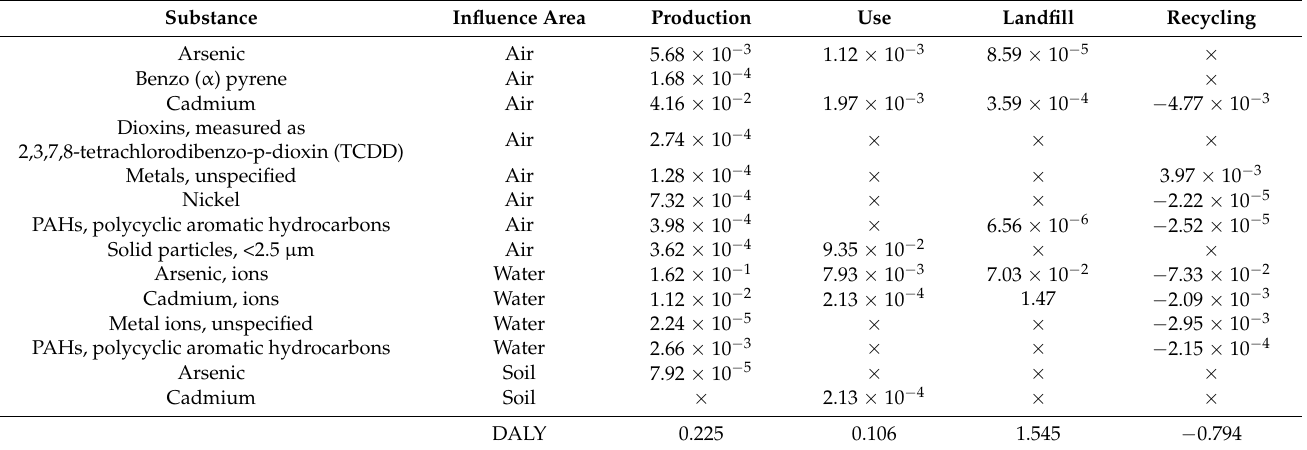
Table 3. The results of the studies characterizing the environmental consequences for carcinogenic compounds occurring in the various stages of the life cycle of the Vestas V90 wind farm, DALY [own